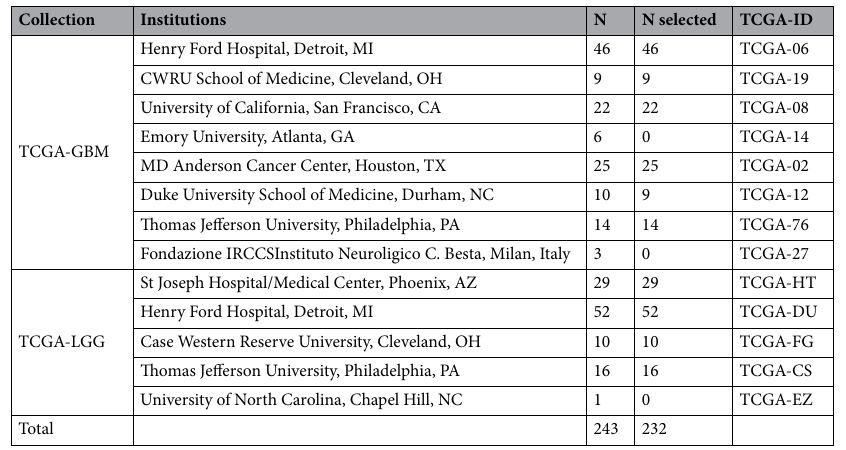
Table 1. Institutional information of patients of Bakas et al. 24 and patients selected in our study. TCGA The Tumor Genome